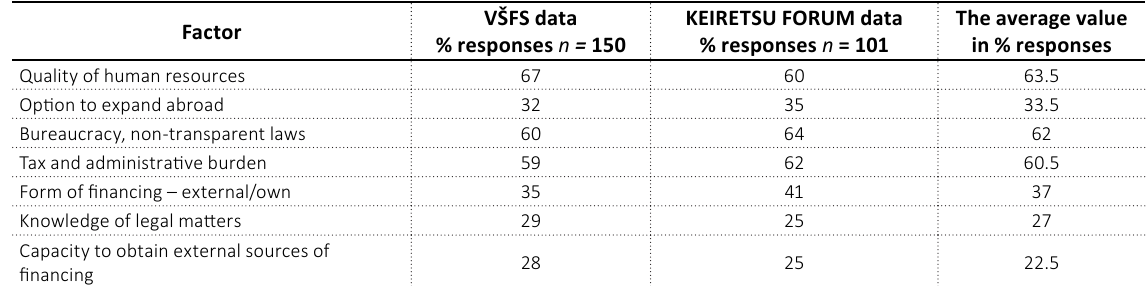
Table 7. Other factors influencing success of startups – processing information from qualitative research, personal interviews with owners of